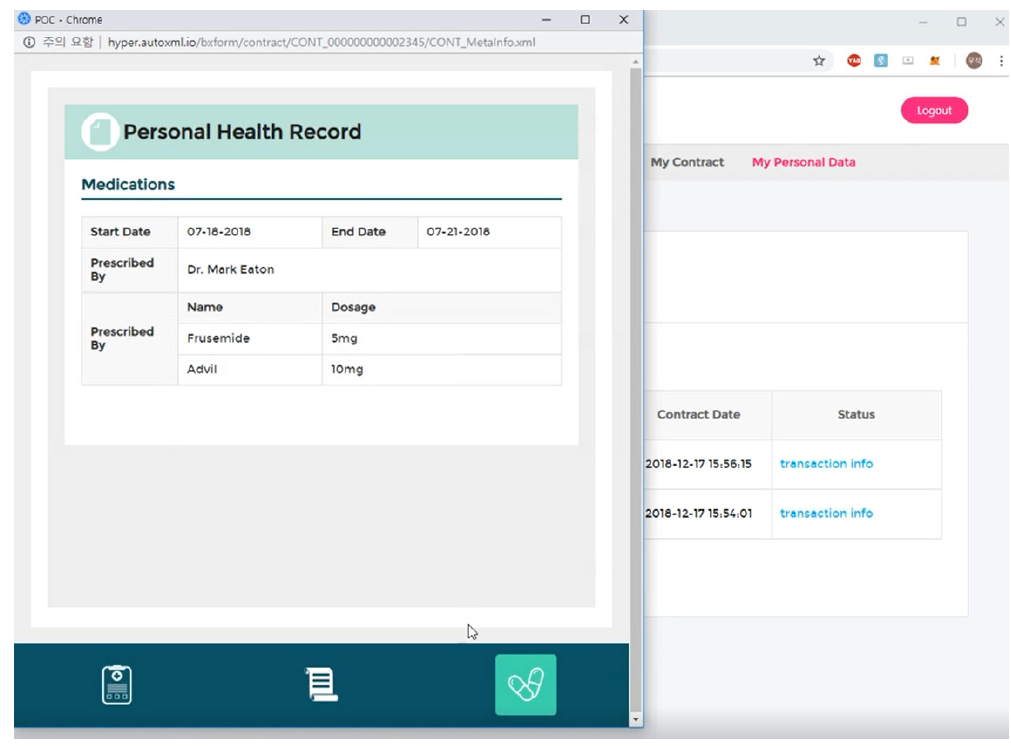
Figure 17. Blockchain PHR privacy and X-ray screen using the neuron network.